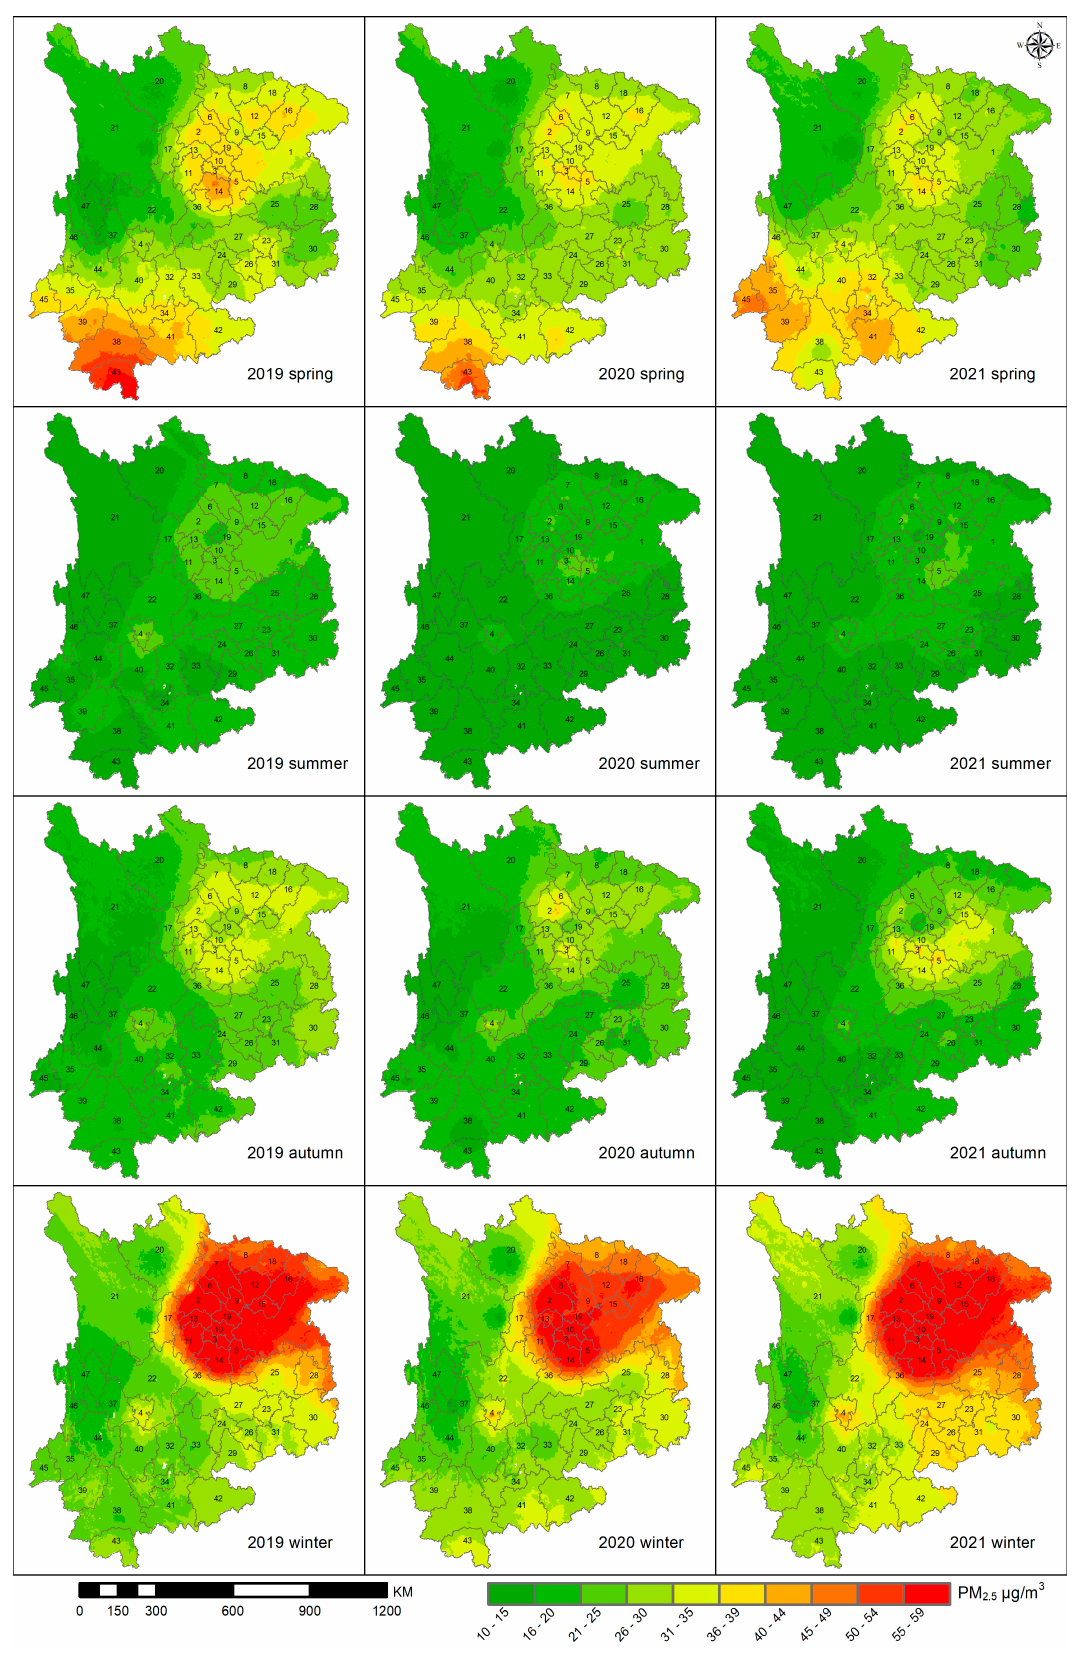
Figure 7. Quarterly changes in PM 2.5 spatial distribution in southwest China.